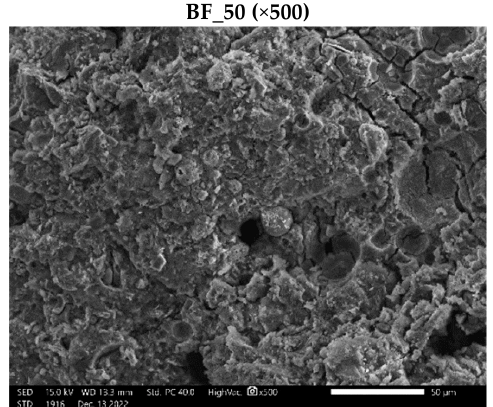
Figure 7. The microstructure SEM photography of produced geopolymers.